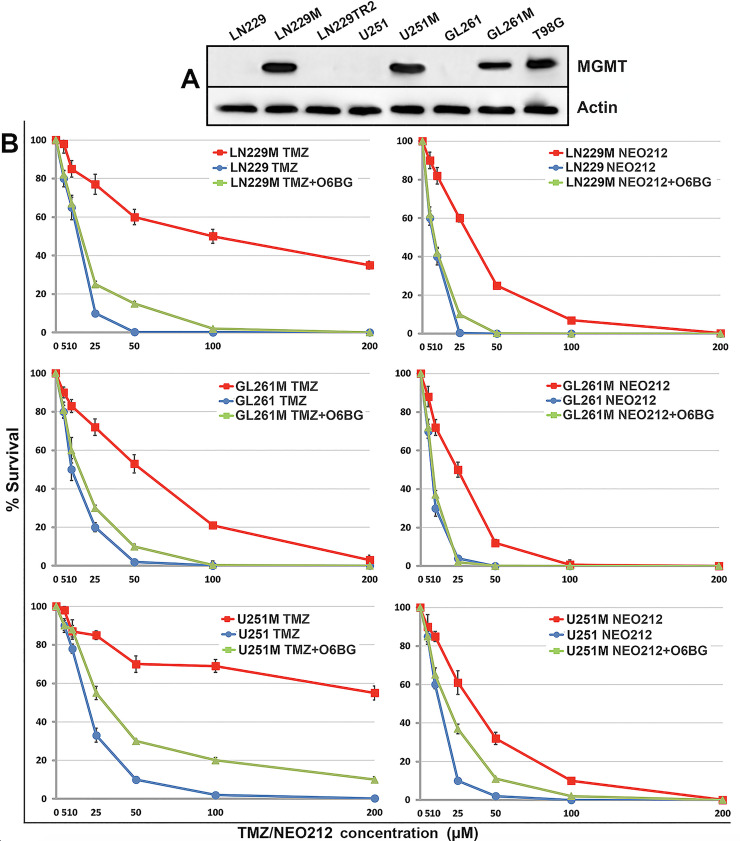
NEO212 is more potent than TMZ over a broad range of concentrations.MGMT-expressing variants (i.e., LN229M, U251M, and GL261M) of three well-established GB cell lines were checked along with their parental cells as well as the T98G (an endogenous high MGMT expressor) and LN229TR2 (an MMR-deficient variant of LN229) GB cells for MGMT expression by Western blotting (panel A). Colony survival data are also shown for all three isogenic GB cell lines (panel B). The O6BG MGMT inhibitor (40 μΜ) was used to demonstrate that the artificially expressed MGMT proteins in LN229M, U251M, and GL261M cells were functional and respond to specific inhibition (i.e., the MGMT-positive cells are sensitized to both alkylating agents after the addition of the O6BG inhibitor).